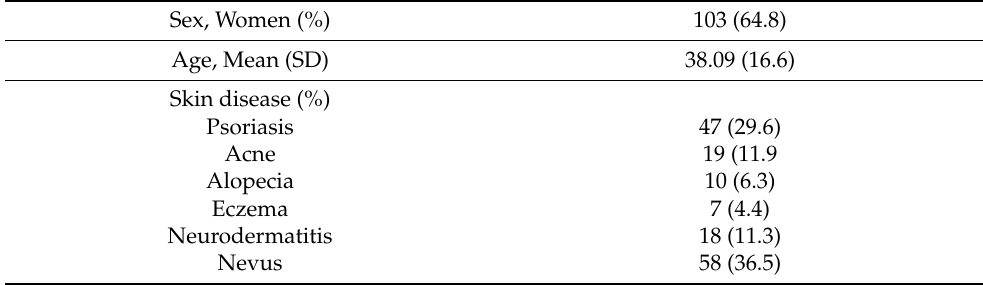
Table 1. Sociodemographic